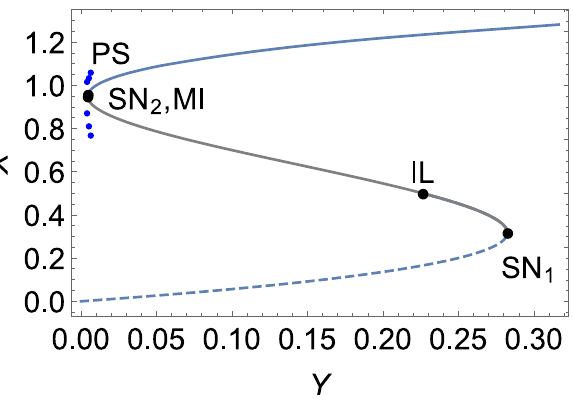
Figure 2: Stationary homogeneous solution of Eq. (3), where the solid and dashed blue lines denote stable and unstable con fi gurations. The blue symbols correspond to a phase soliton branch from numerical simulations of Eq. (3) with η max = 200 (the symbols indicate the maximum and minimum intensity). Δ = G = 1.1, θ = 1 (point a of Figure